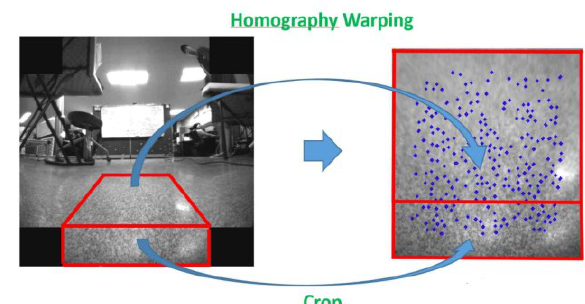
Figure 6 . Generate Ground Plane Image from the cube